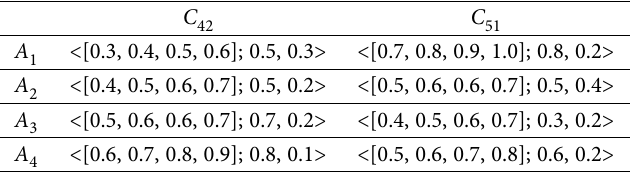
Table 1. Decision-making